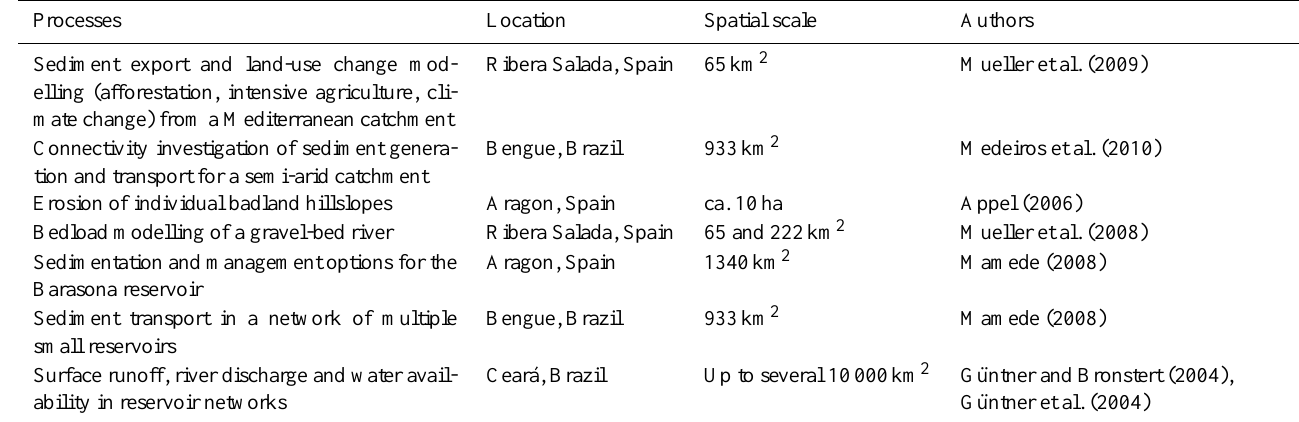
Table 9. Summary of current WASA-SED model